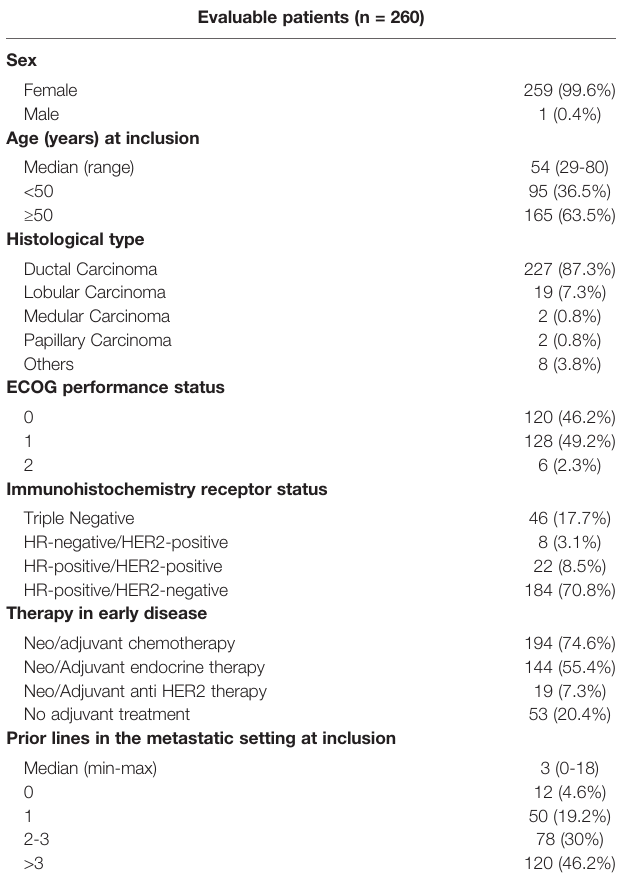
TABLE 1 | Patients